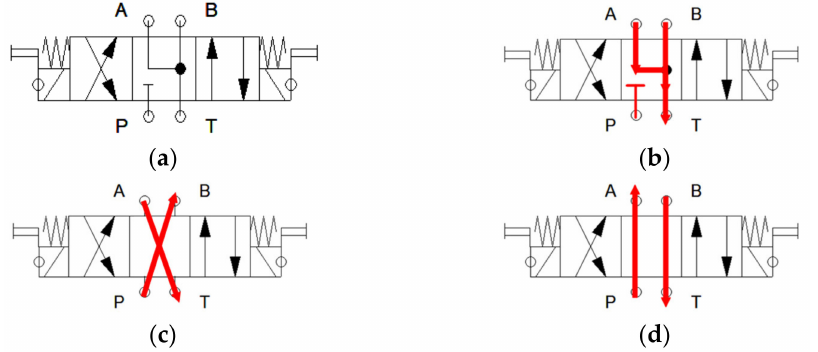
Figure 3. Landing gear selector valve and its working state: ( a ) landing gear selector valve; ( b ) neutral function; ( c ) left position status; ( d ) right position